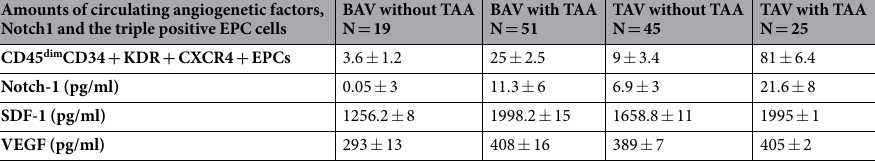
Table 3. Simple comparison of amounts of circulating angiogenetic factors, Notch1, and the triple positive EPC cells.